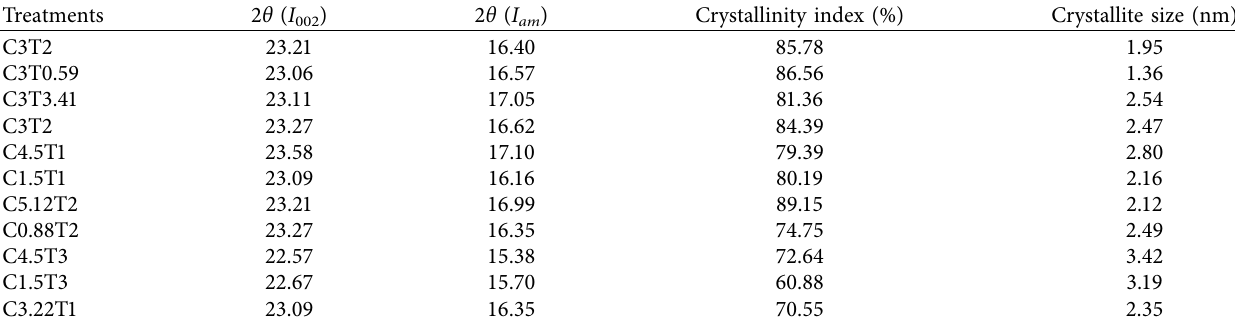
Table 8: Data on the crystallinity index and crystallite size of cellulose extracted from OPEFB fber.